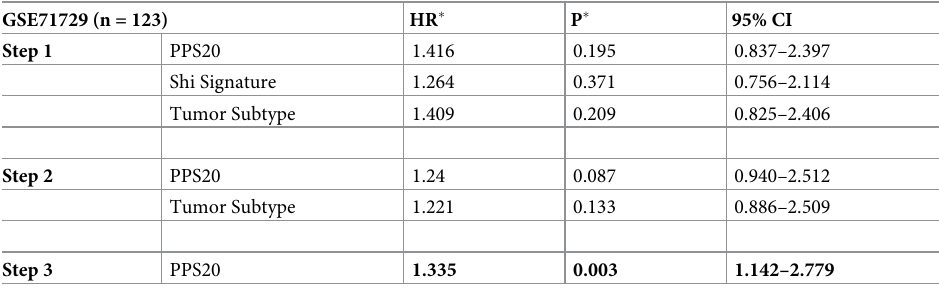
Table 2. Multivariate analyses (Backward